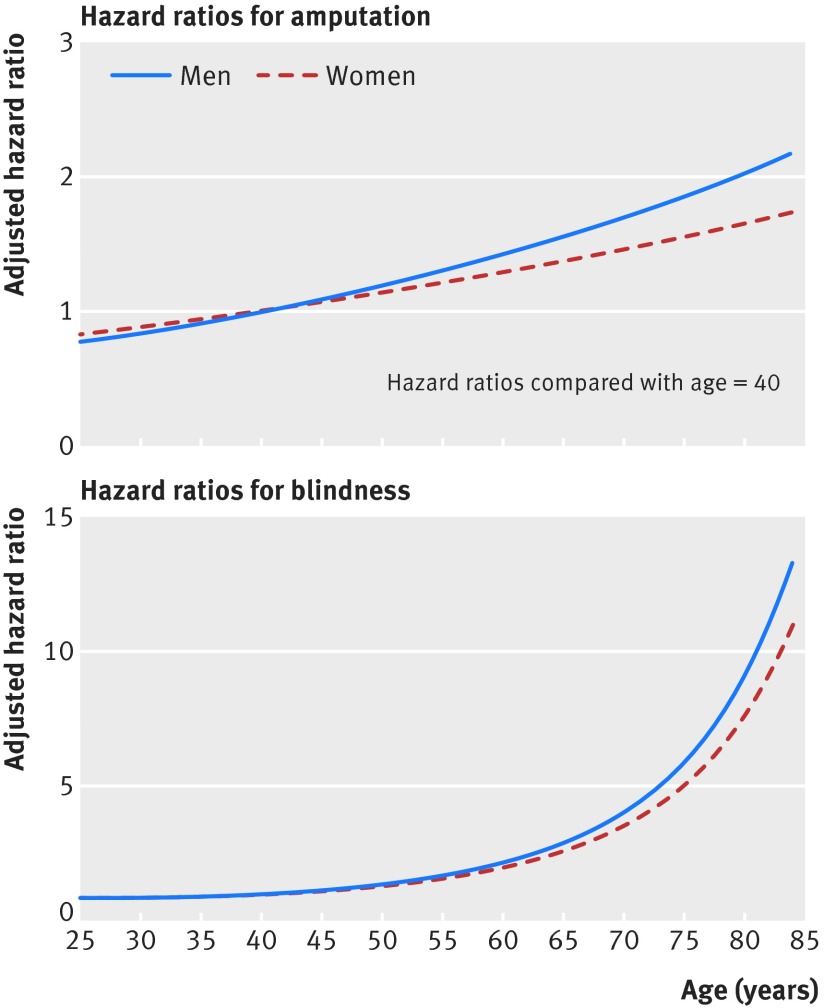
Fig 1 Adjusted hazard ratios for blindness and lower limb amputation by age in derivation cohort